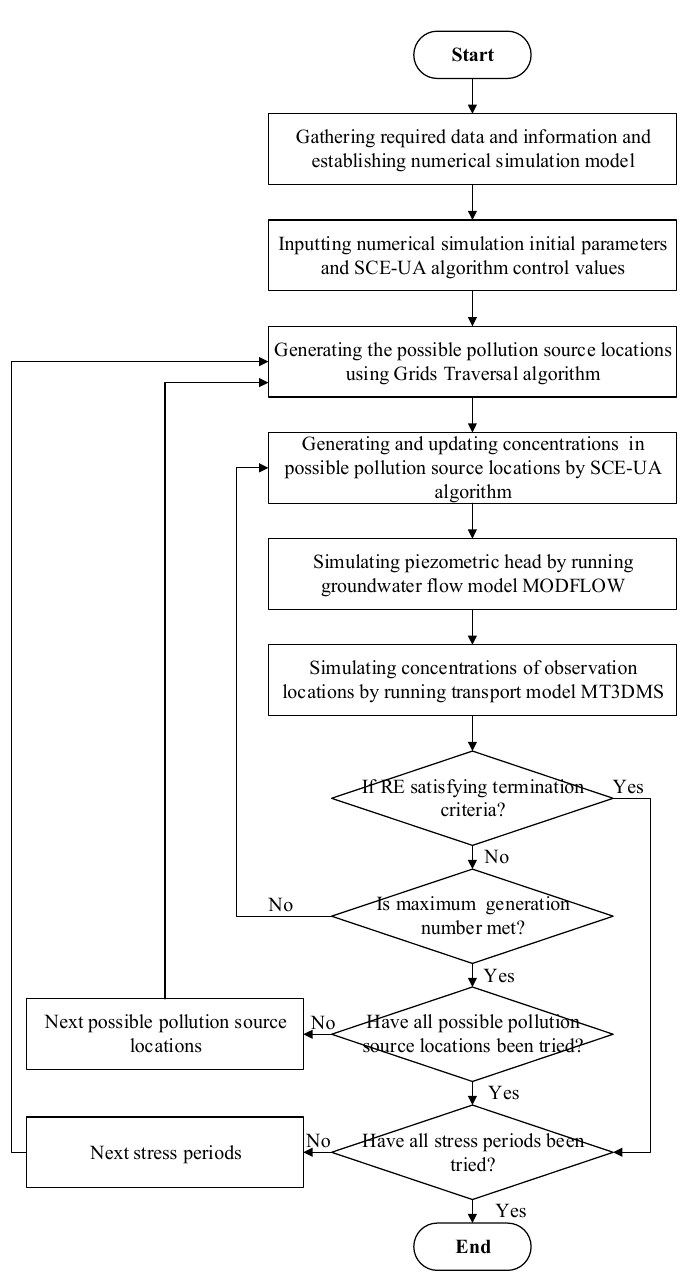
Figure 5. Schematic representation of linked simulation-optimization (S/O) model using the SCE-UA optimization algorithm.